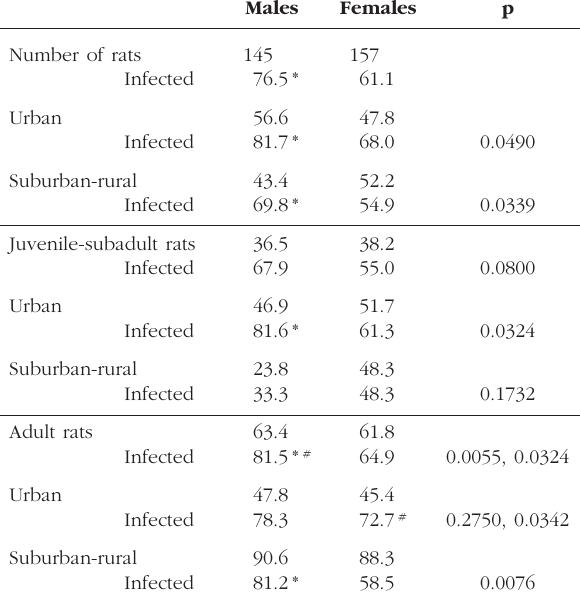
Table I. – Prevalence of intestinal helminth infection in rats of dif- ferent sex, age and from different